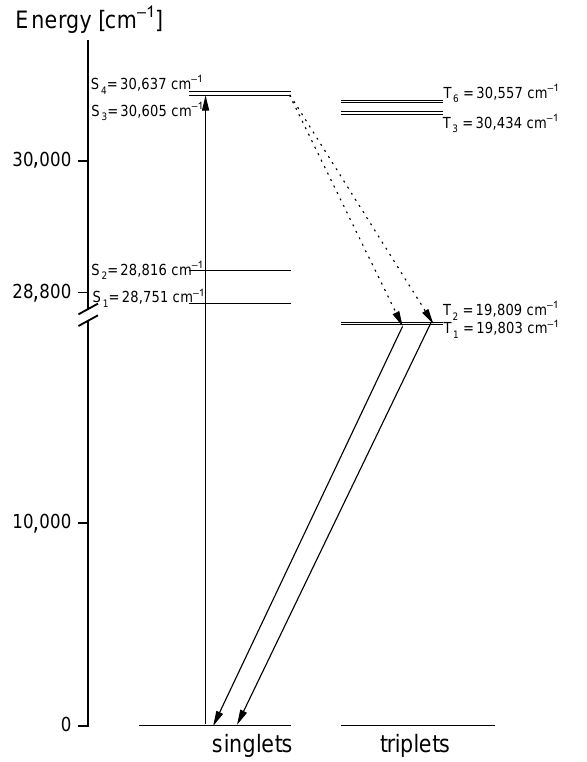
Figure 11. Depopulation mechanism of the excited states proposed for the studied a 1,2,4-triazolo[4,3- a ]pyridin-3-amine.